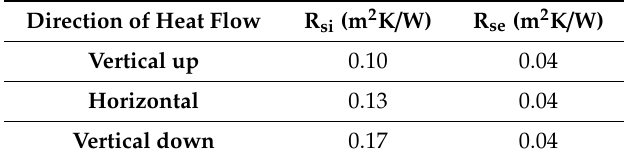
Table 3. Thermal resistance values for heat transfer on external and internal walls [67]. Direction of Heat